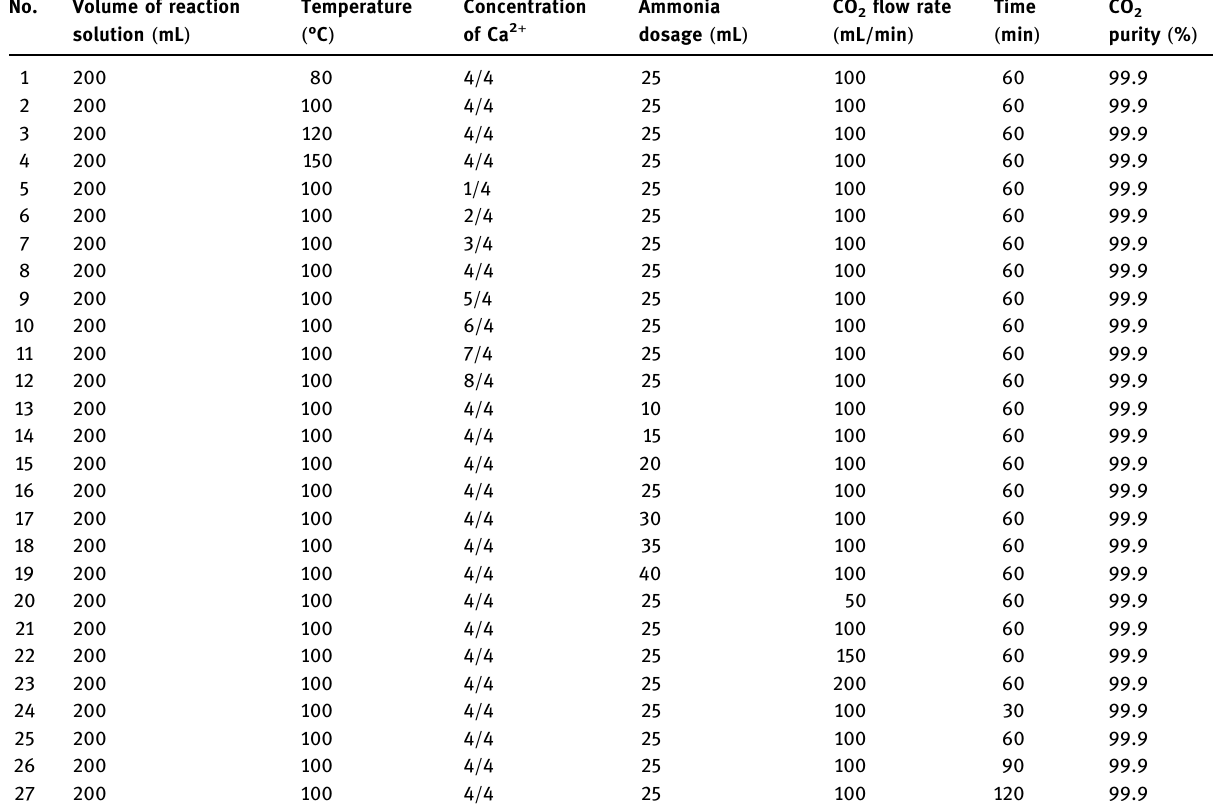
Table 2: Factors and levels of aragonite preparation experiments No. Volume of